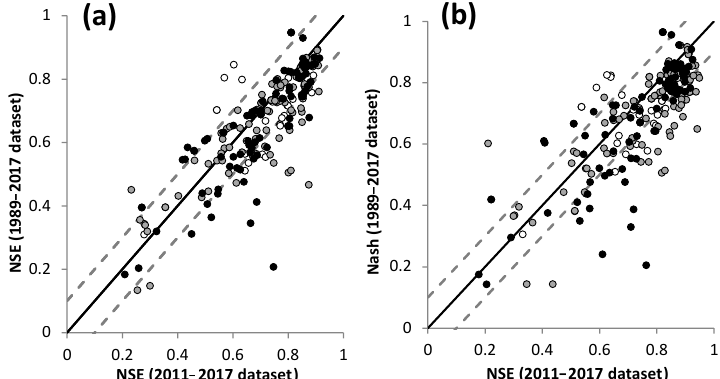
Figure 8. NSE calculated for each HER2–HR combination between 2012 and 2016 with the 1989–2017 dataset as a function of NSE calculated with the 2011–2017 dataset with, respectively, (a) the LLR model and (b) the LR model. The colours of the dots represent the proportion of gauging stations and piezometers lost between the 2011–2017 database and the 1989–2017 database: losses<50% (white); losses between 50 and 75% (grey); losses>75%